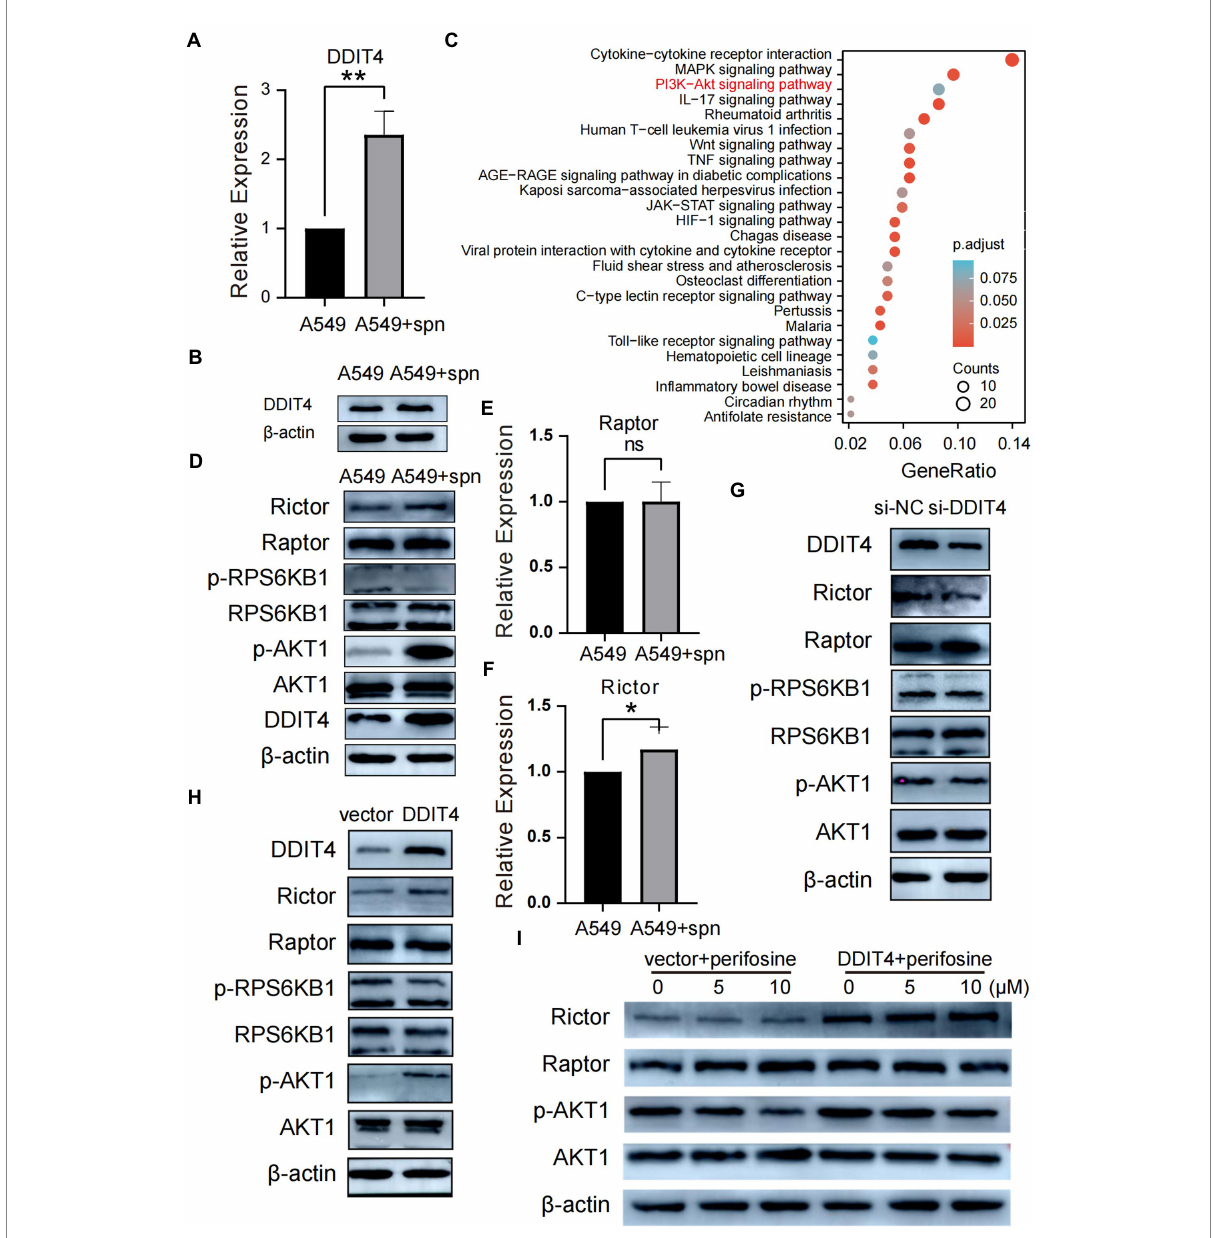
FIGURE 4 Up-regulated DDIT4 regulates the mTORC2/AKT signaling pathway. (A) Differential expression of the DDIT4 gene in the co-culture and A549 control groups was analyzed using qPCR, ** P < 0.01. (B) The differential expression of DDIT4 protein in the co-culture and A549 control groups was analyzed by WB. (C) KEGG enrichment analysis based on significantly differentially expressed genes between the co-culture group and the A549 control group. (D) Compared with the control group, the expression of Rictor and phosphorylated AKT (p-AKT) in A549 cells in the co- culture group was up-regulated. At the same time, the remaining proteins had no significant change. (E,F) qPCR similarly confirmed that the Rictor gene but not the Raptor gene was up-regulated in the co-culture group, * P < 0.05. (G) Silencing of the DDIT4 gene resulted in reduced expression of Rictor and p-AKT without significant effects on other proteins. (H,I) Overexpression of DDIT4 up-regulated the expression of Rictor and p-AKT1, which was inhibited by the addition of AKT inhibitor